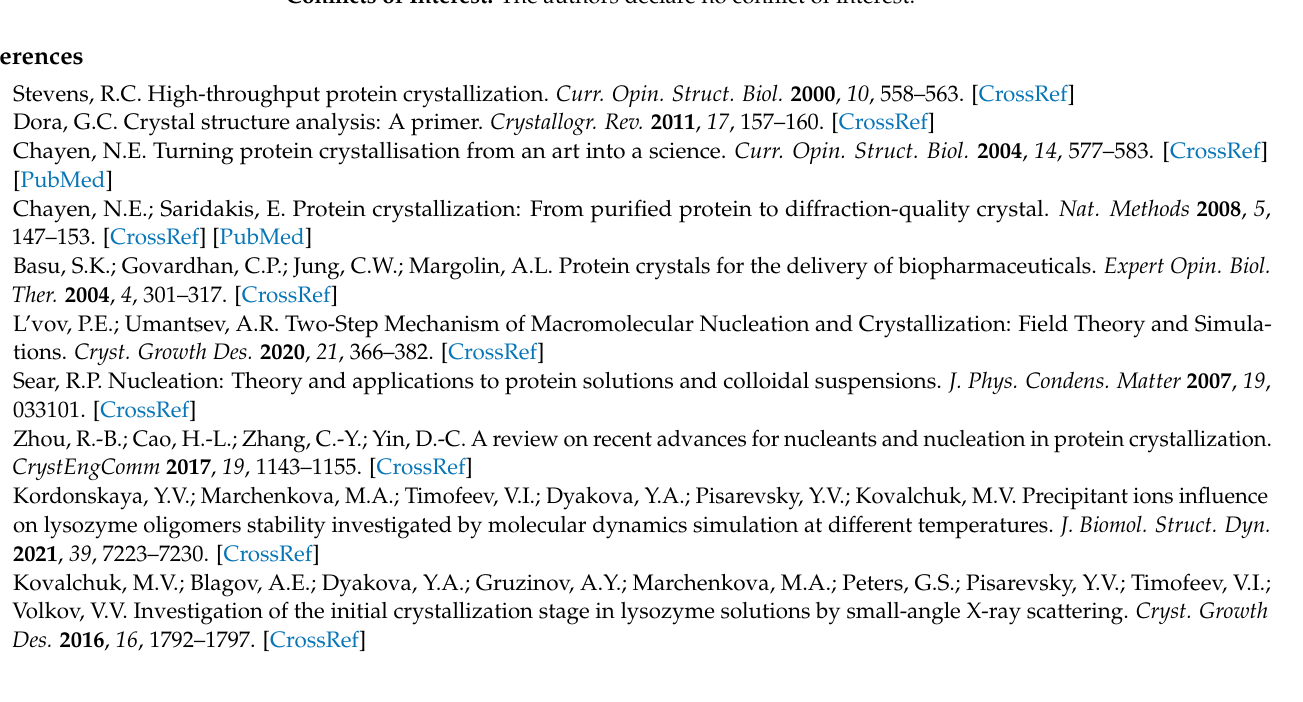
particle sizes; Figure S6. UV spectra of lysozyme at different concentrations; Figure S7. CD spectra of lysozyme in the presence and absence of